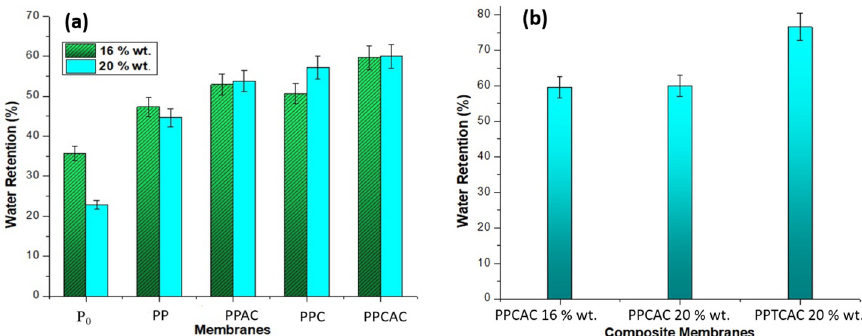
Figure 7. Water retention bar graph for ( a ) 16 and 20% PES membranes, and ( b ) composite mem- branes.